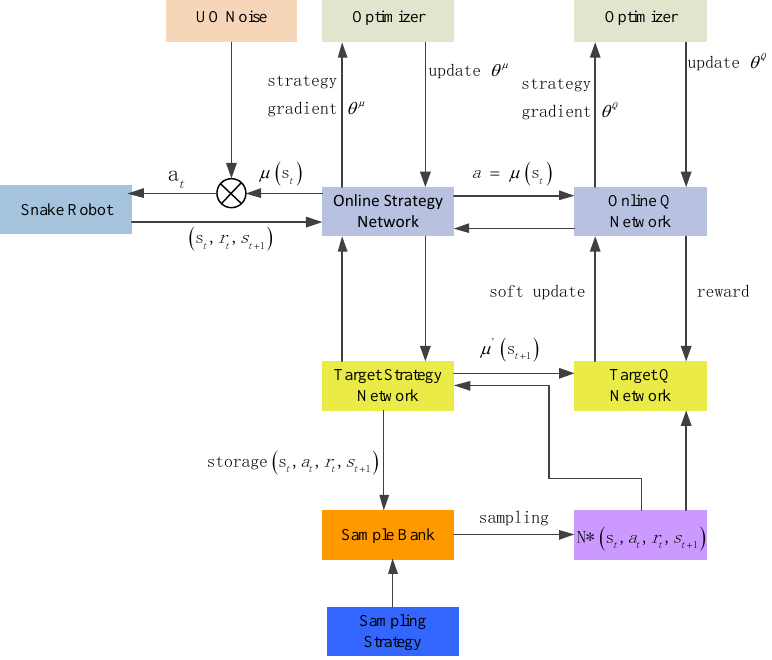
Figure 1. DDPG network